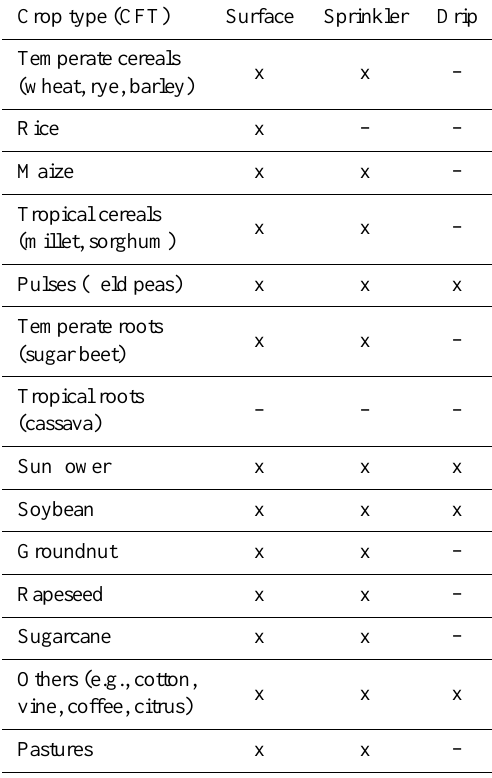
Table 2. Biophysical and technical irrigation system suitability by crop type (CFT), based on Sauer et al. (2010) and Fischer et al.